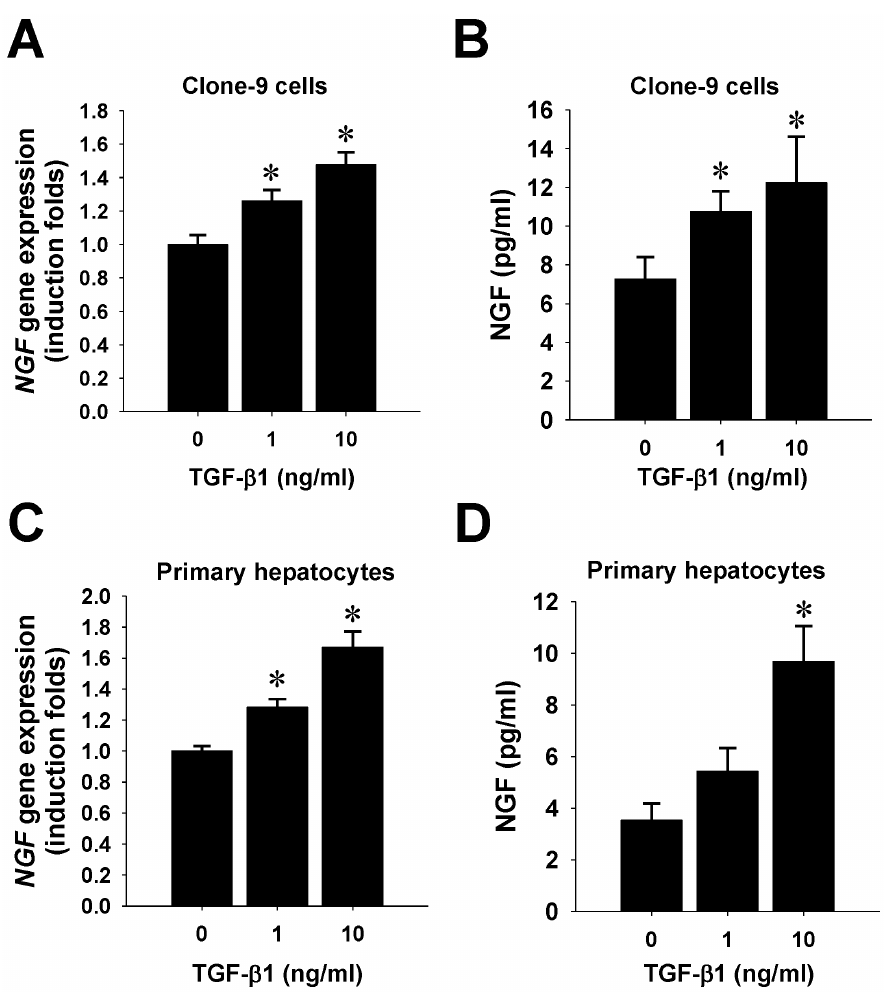
Figure 4. Up-regulation of NGF expression in rodent hepatocytes by TGF- b 1. Both clone-9 and primary rat hepatocytes were used for NGF induction experiments. Clone-9 cells (A, B) and primary hepatocytes isolated from rats (C, D) were grown on collagen I-coated dishes and treated with TGF- b 1 at the indicated doses (ng/mL) for 6 h. Total RNA was extracted and subjected to qPCR analysis for NGF mRNA levels (A, C). Besides, conditioned media for 24 hrs of treatment were collected for NGF ELISA detection (B, D). Note that TGF- b 1 at 10 ng/mL remarkably increased de novo synthesis of NGF in both cultured hepatocytes. Data are representative results from three independent experiments and shown in mean 6 SD. * indicates P , 0.05 compared to negative control